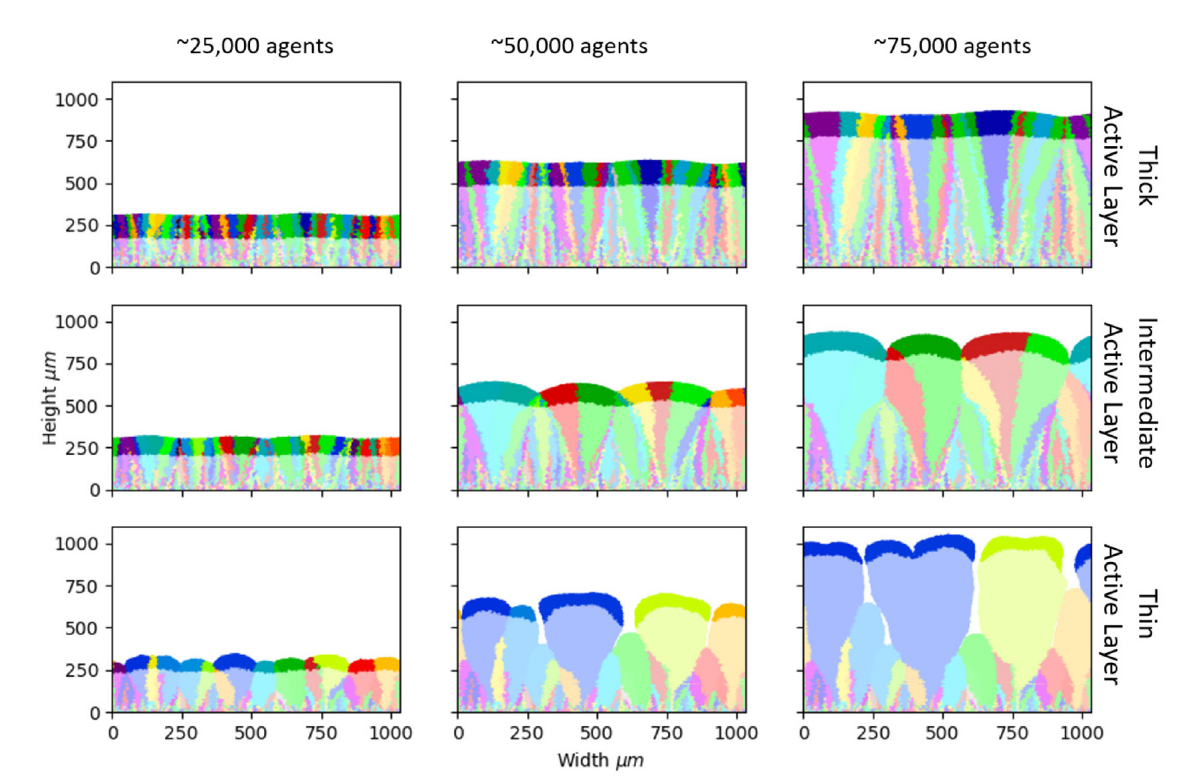
FIGURE1 Biofilm morphology and loss of standing diversity. Snapshots from our simulations at different stages of biofilm growth (left to right: 25,000, 50,000, and 75,000 microbial agents). The active layer is shown by the shaded region (see section Methods for definition). Three simulations are shown ( top, middle , and bottom rows), with different parameters and hence different values of the active layer thickness. (Top) S bulk = 0.01 g/L; µ Table 1. The descendants of each of the 300 founder cells are shown in a different color, allowing visualization of the patterns of loss of standing